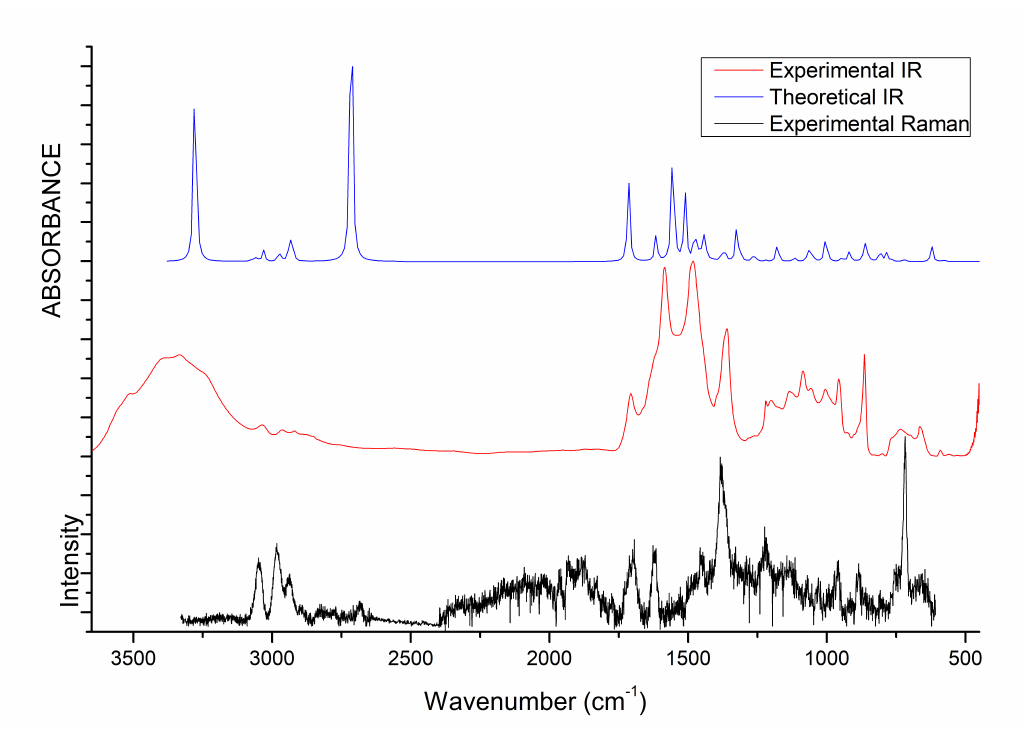
Figure 9. IR and Raman spectra of [Ch][H-maleate] liquid. B3LYP values are scaled for 0.96